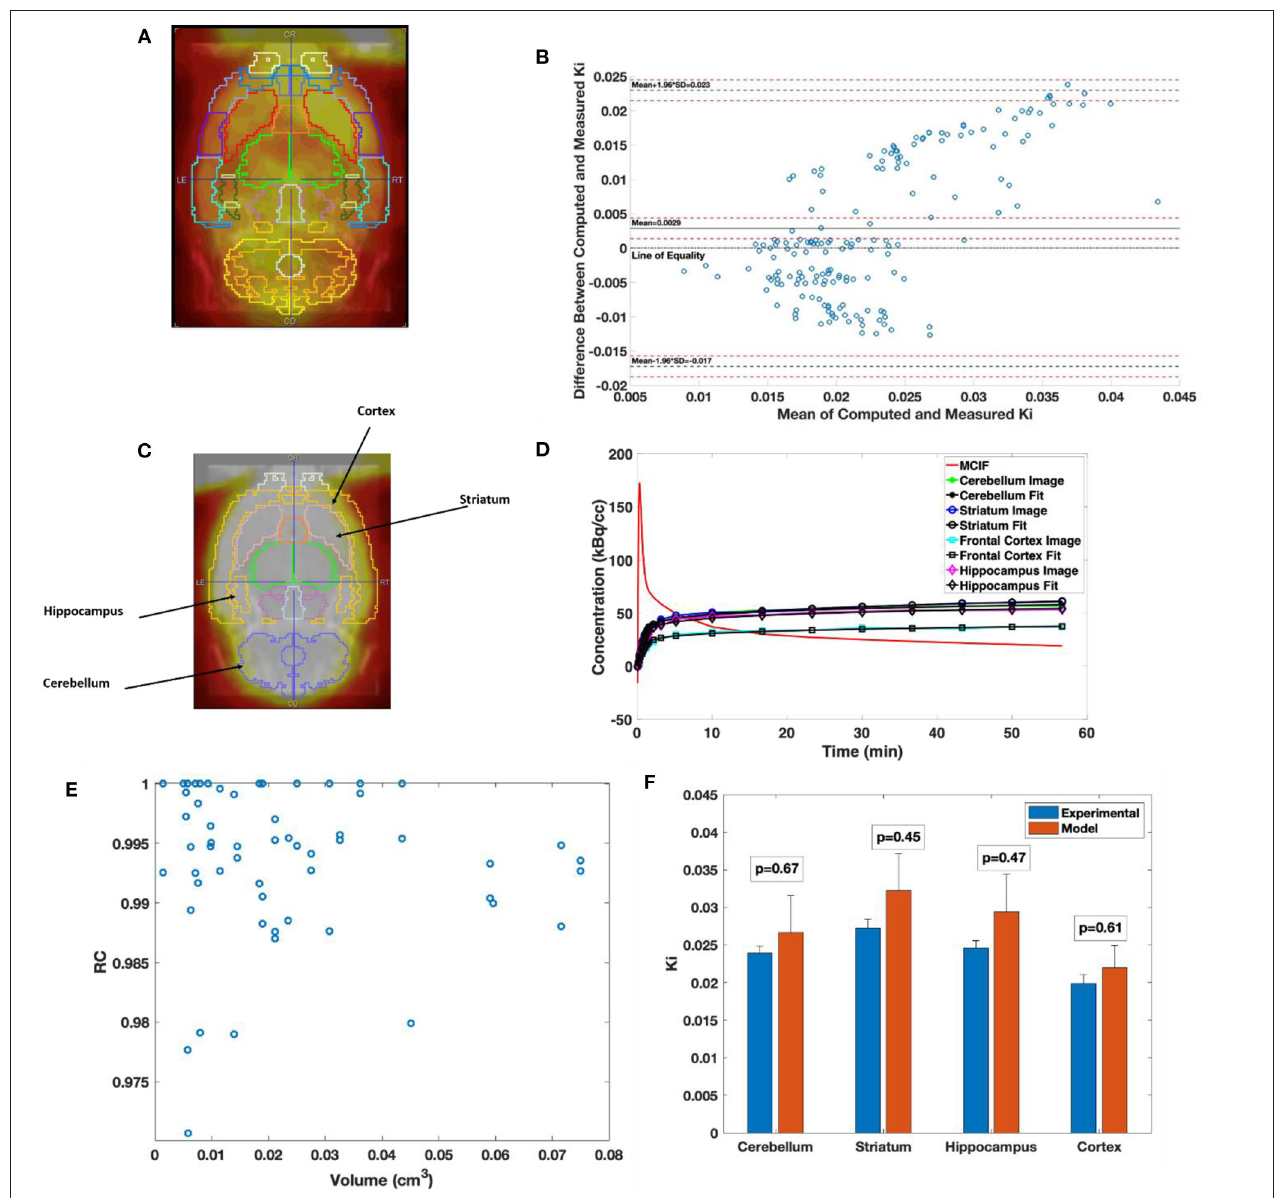
FIGURE 5 | Computed cerebral 2-[18F] fluoro-2-deoxy-D-glucose (FDG) uptake rates in Wistar–Kyoto (WKY) rats. (A) Example brain PET image of WKY rat co-registered onto W. Schiffer T2 rat brain atlas showing 35 volumes of interest. (B) Bland–Altman plot comparing computed model and experimental Ki. (C) Example brain PET image of WKY rat co-registered onto W. Schiffer T2 rat brain atlas combining the 35 volumes of interest (VOIs) into four regions of interest. (D) Four-parameter compartment model fitted to time activity curves (TACs) derived from the dynamic PET data for the regions indicated in panel C . (E) Recovery coefficient (RC) of all the 58 VOIs derived from the atlas for an example WKY rat. (F) Comparison between experimental and computed K i for the cerebellum, striatum, hippocampus, and frontal cortex.